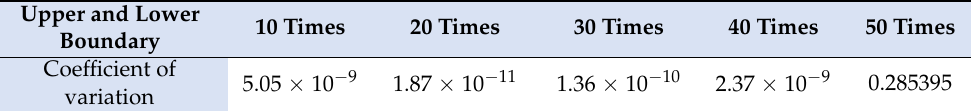
Table 6. Optimization of acoustic resistance of ventilation cloths, upper and lower boundary tests (Remarks: 30 particles, 50 iterations).